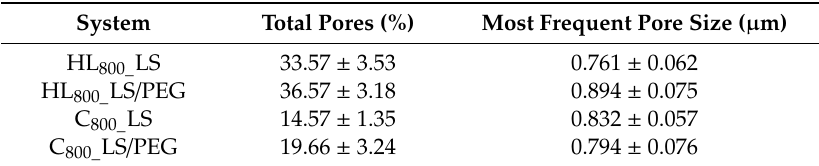
Figure 3. Porosimetric features by image analysis of the SEM micrographs in Figure 2: ( a ) percentage of pores as a function of their diameter; ( b ) number of pores per classes of pore-size. Table 2. Total pores as a percentage and the most frequent pore size obtained by image analysis of SEM micrographs taken on the investigated